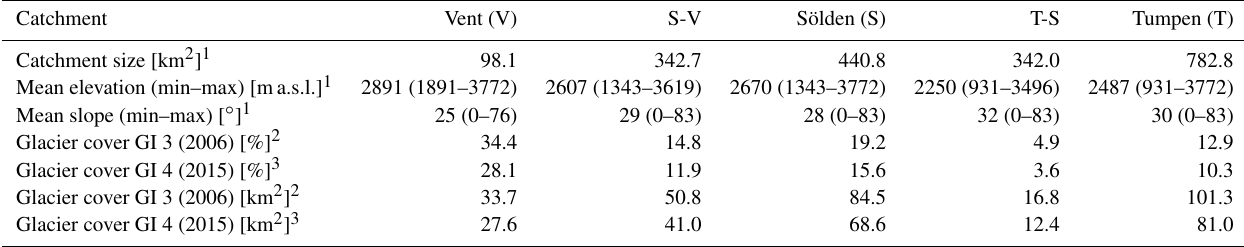
Table 1. Characteristics of the sub-catchments. Catchment